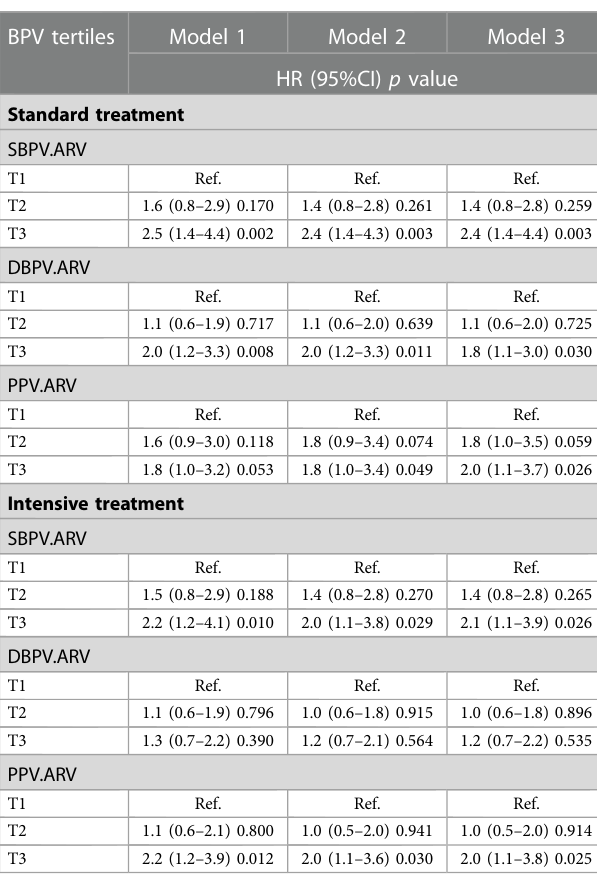
TABLE 3 Association between BPV (SBPV, DBPV and PPV) and PD in different blood pressure treatment arms.